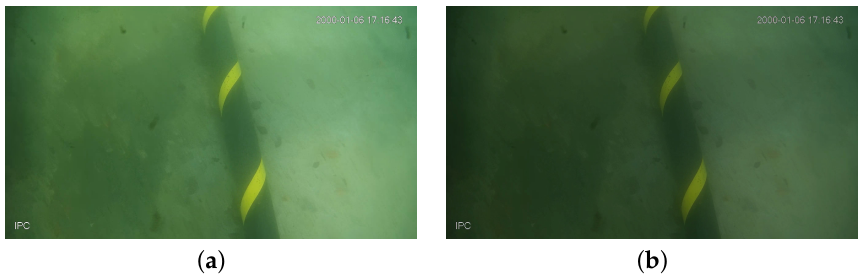
Figure 1. Partial sample brightness transformation: ( a ) original image, ( b ) brightness